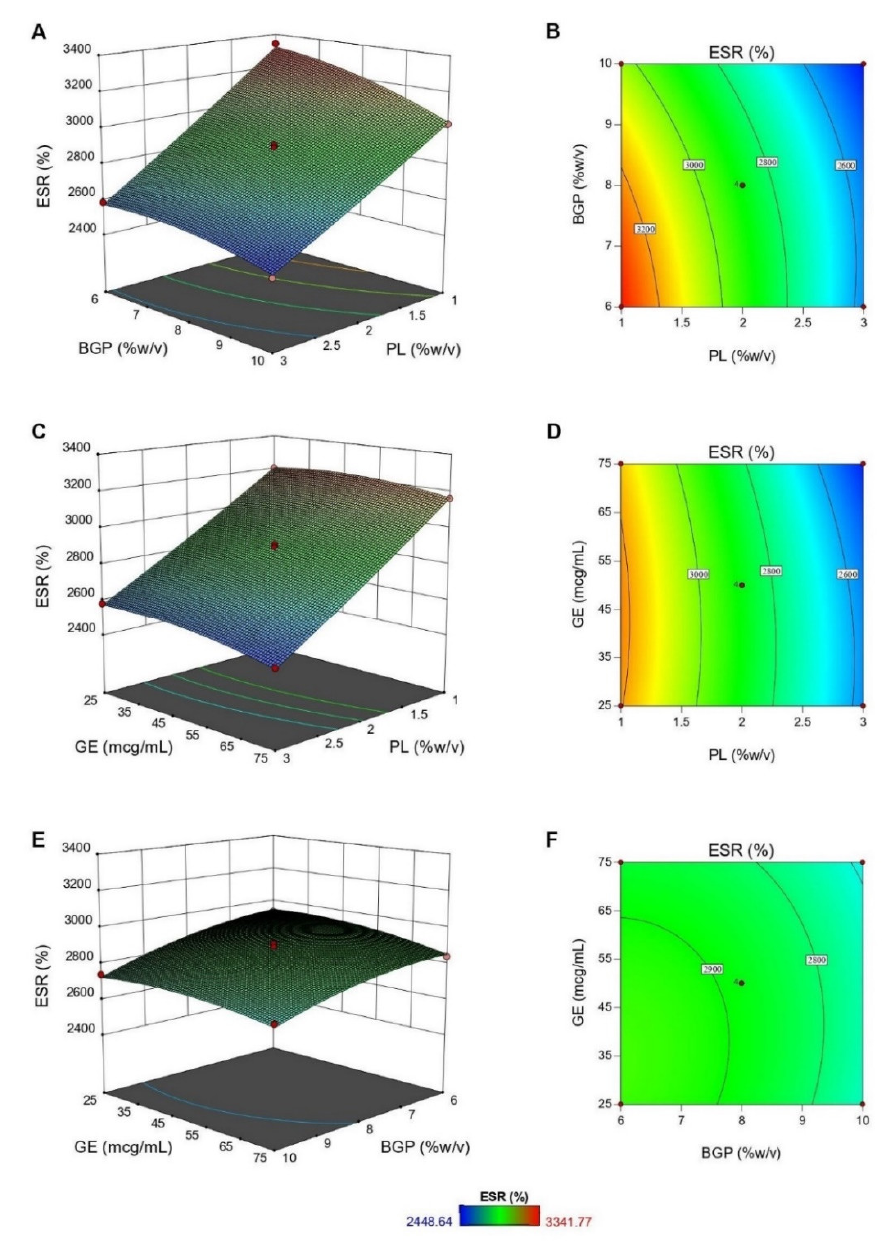
Figure 5. The response surface plots showing the interaction e ff ects of PL and BGP ( A ), PL and GE ( C ), andBGPandGE( E )onpercentageofequilibriumswellingratio(%ESR),togetherwiththecorresponding contour plots ( B , D , F